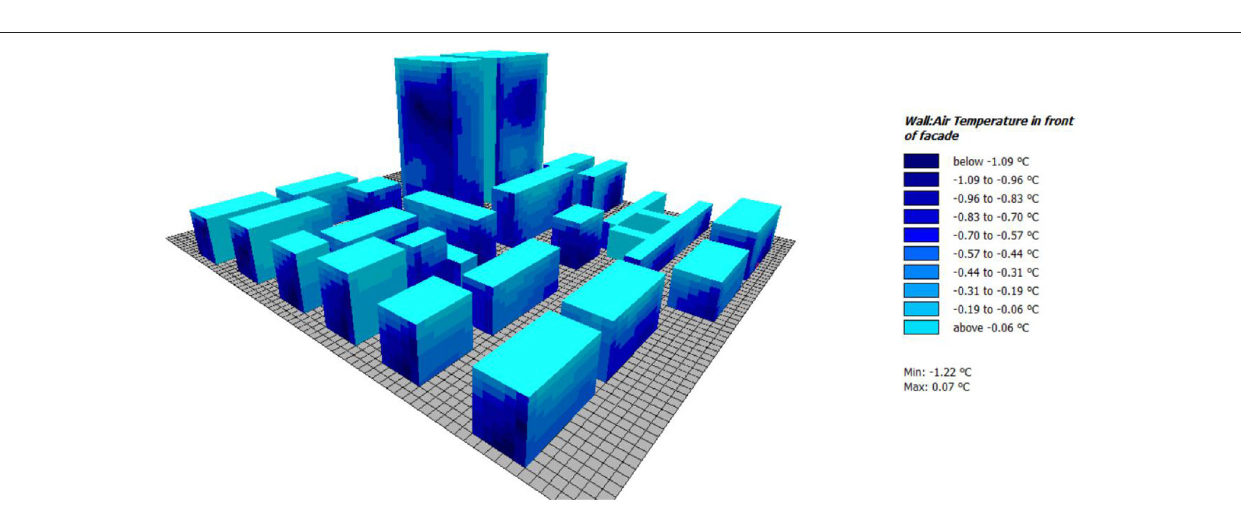
FIGURE 16 | 1 Ta distribution of building exterior wall between optimal design and current situation (at